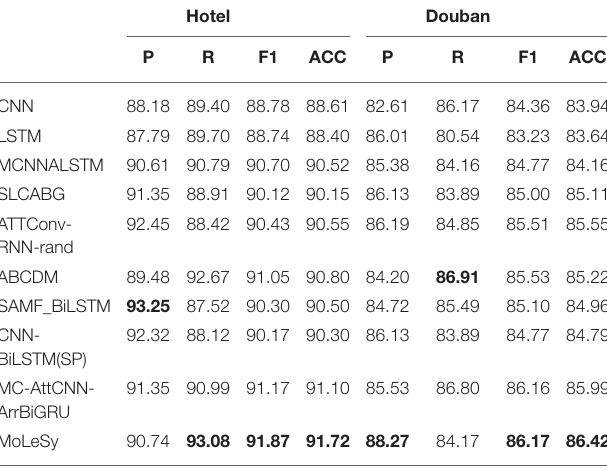
TABLE 4 | The accuracy of different models on the Hotel and Douban.